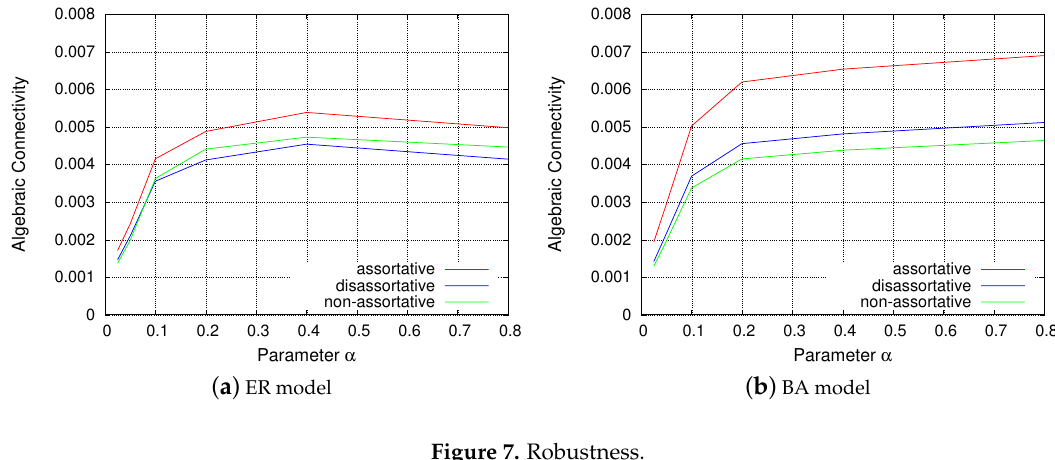
Figure 7. Robustness.